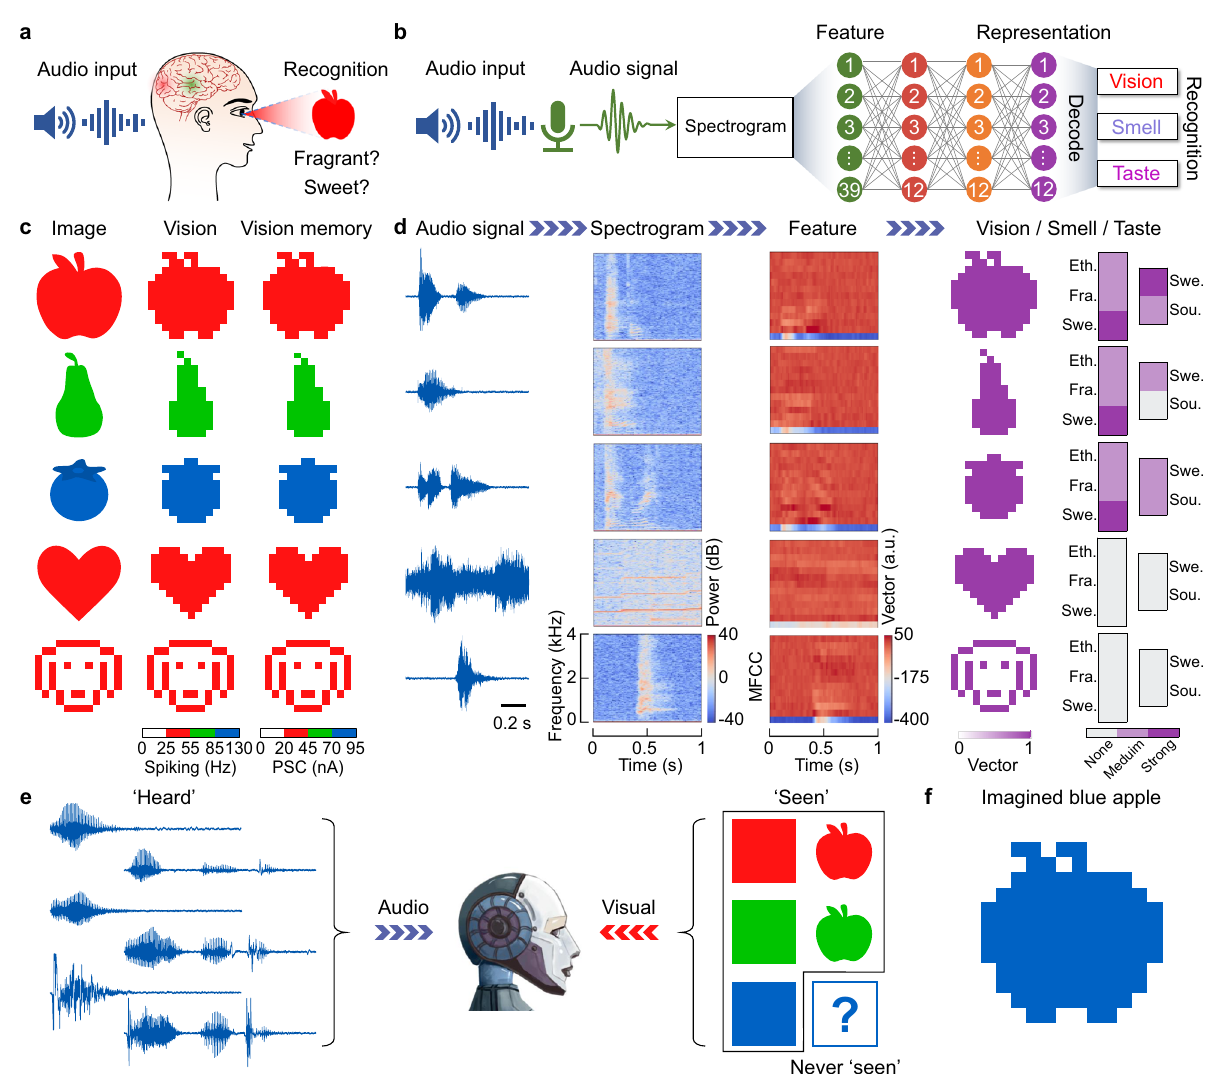
Fig. 5 Auditory-visual/smell/taste crossmodal recognition and imagination. a Illustration of the human ability to recognize and visualize audio input. b Schematic of the arti fi cial auditory-vision/olfactory/gustatory system. Mel spectrograms convert the audio inputs into 13 × 3-dimensional features feeding the ANN. Visual data processed by 12 × 12 photodetectors and photomemristors, together with olfactory and gustatory vectors